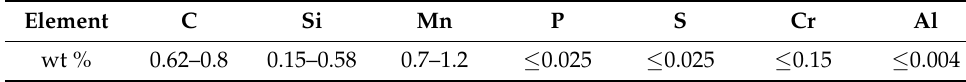
Table 1. Chemical composition of R260 steel.